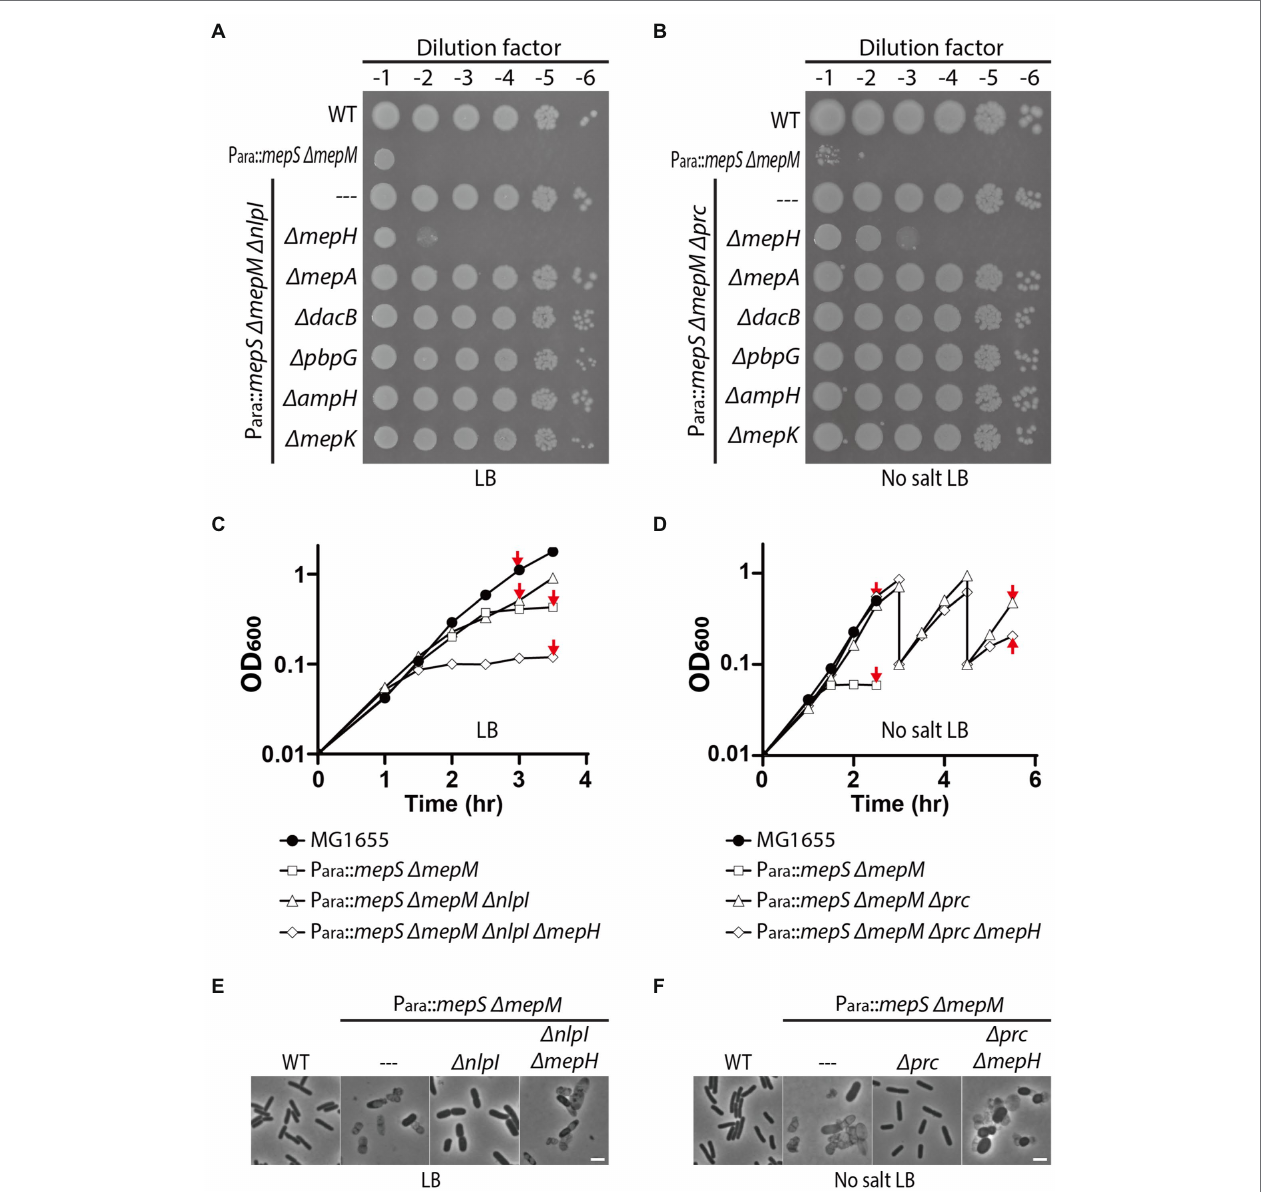
FIGURE 3 | MepH is required for suppression of the mepS mepM mutant growth defect by inactivation of Prc or NlpI. (A,B) Spot dilution assay of HC611 derivative strains to identify DD-endopeptidases required for suppression of the synthetic lethality between the mepS and mepM mutations. DD-endopeptidase mutant derivatives of the nlpI suppressor strain (WJ76, P ara :: mepS , Δ mepM , Δ nlpI ) were spotted on LB agar (A) and the mutant derivatives of the prc suppressor (WJ81,